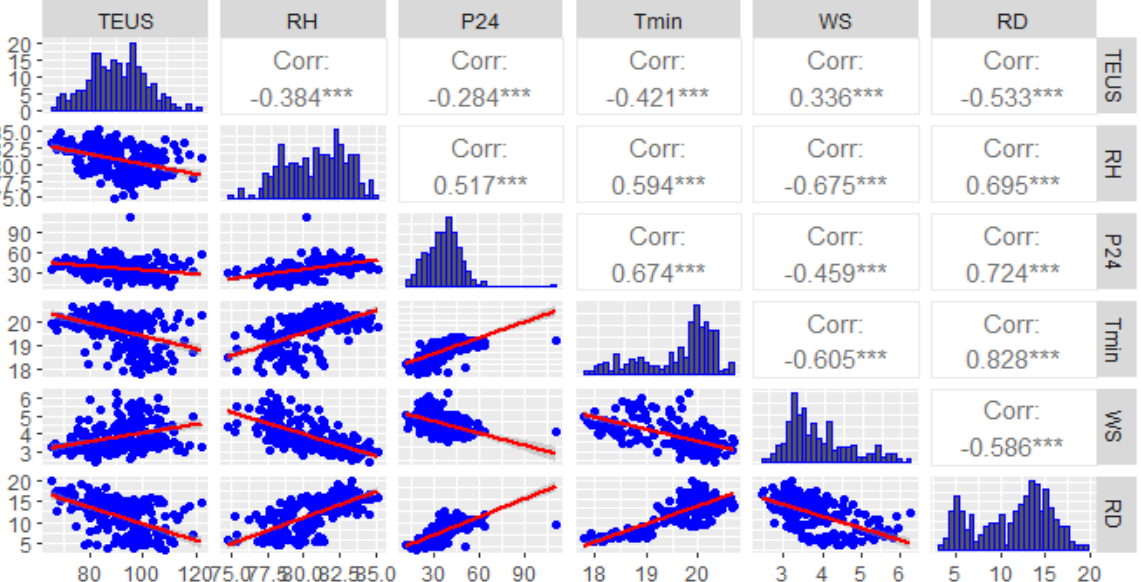
Figure 15. Scatterplot matrix of Spearman correlation. [*** indicates statistically significant p < 0.0001]. Table 6. Multivariate time series analysis of Geoclimatic factors and Malaria